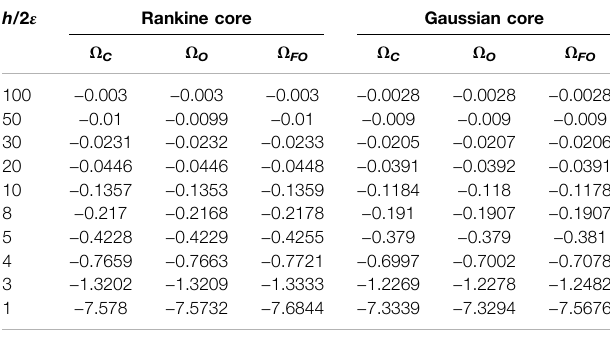
TABLE 1 | Values of the angular velocity of the helical vortex of Rankine and Gaussian